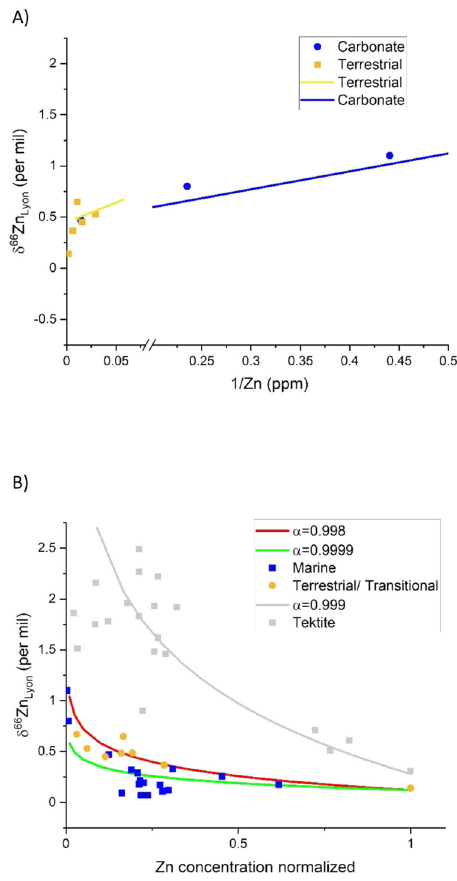
Fig. 3 Modeled Zn isotope data by distillation. A Zn isotope data from the carbonate and transitional/ terrestrial environment showing two different mixing trends. Larger portions of the volatilized Zn signature are found in the lower Zn concentration data. B Zn isotope composition ( δ 66 Zn) vs. boundary sedimentary layers. Zn concentrations have been normalized such that data can be directly compared. Gray squares represent literature data for tektites 47 . The gray dashed line represents the theoretical Rayleigh distillation curve for α = 0.999 (empirical fractionation factor) with an initial δ 66 Zn of 0.28 ‰ (BSE). Blue circles represent sample data for shallow and deeper water marine sites (Mississippi and New Jersey, respectively), and green triangles represent sample data for terrestrial and transitional sites (Montana and Missouri, respectively). The red dashed lines represent factors, α e = 0.9998 and α e = 0.9999 (top and bottom, respectively)